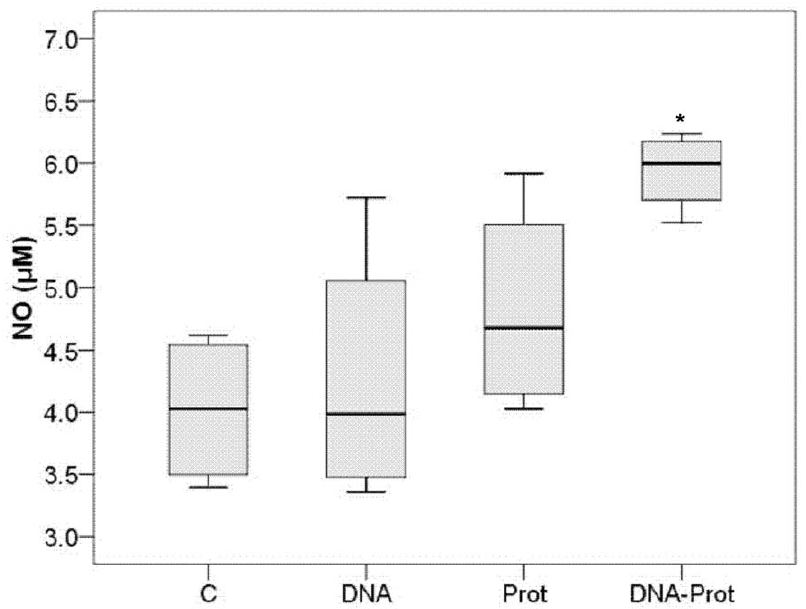
Figure 1. Box plot displaying minimum, first quartile, second quartile (median), third quartile, maximum, and outliers of the production of NO achieved using different vaccination strategies. Production of NO by Leishmania infantum –infected macrophages obtained from hamsters vaccinated with KMPII, TRYP, LACK, and PAPLE22 in the form of raw extracts of Trichoplusia ni larvae producing recombinant proteins (PROT; n=4), naked plasmid (DNA; n=4), both vaccines combined in a prime-boost strategy (DNA-PROT; n=4), and in control hamsters (C; n=4). Each sample was analyzed in triplicate. (* P= 0.029).